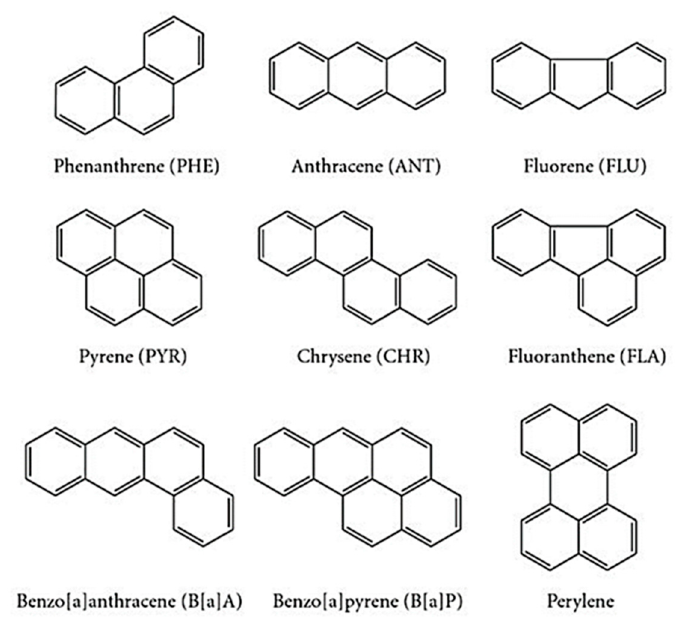
Figure 1. Most important PAHs investigated.